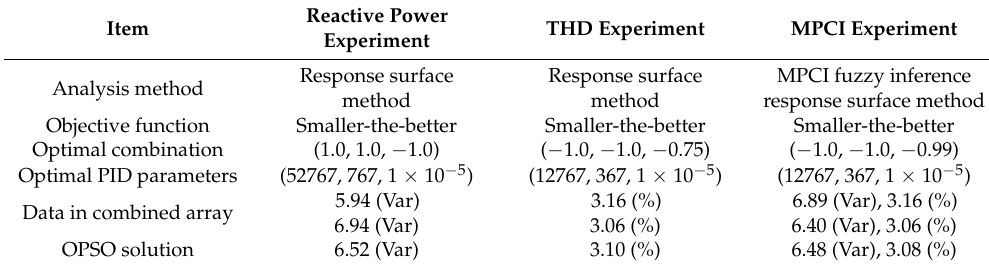
Table 9. Comparison among testing results analyzed by proposed statistical cloud